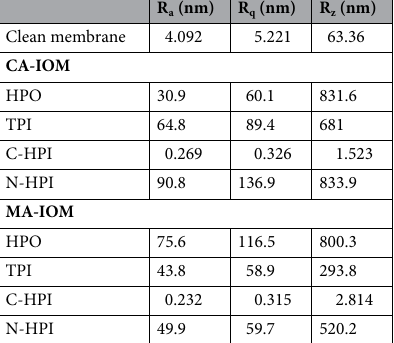
Table 2. Quantitative summary of the roughness parameters determined for various fouled membranes.